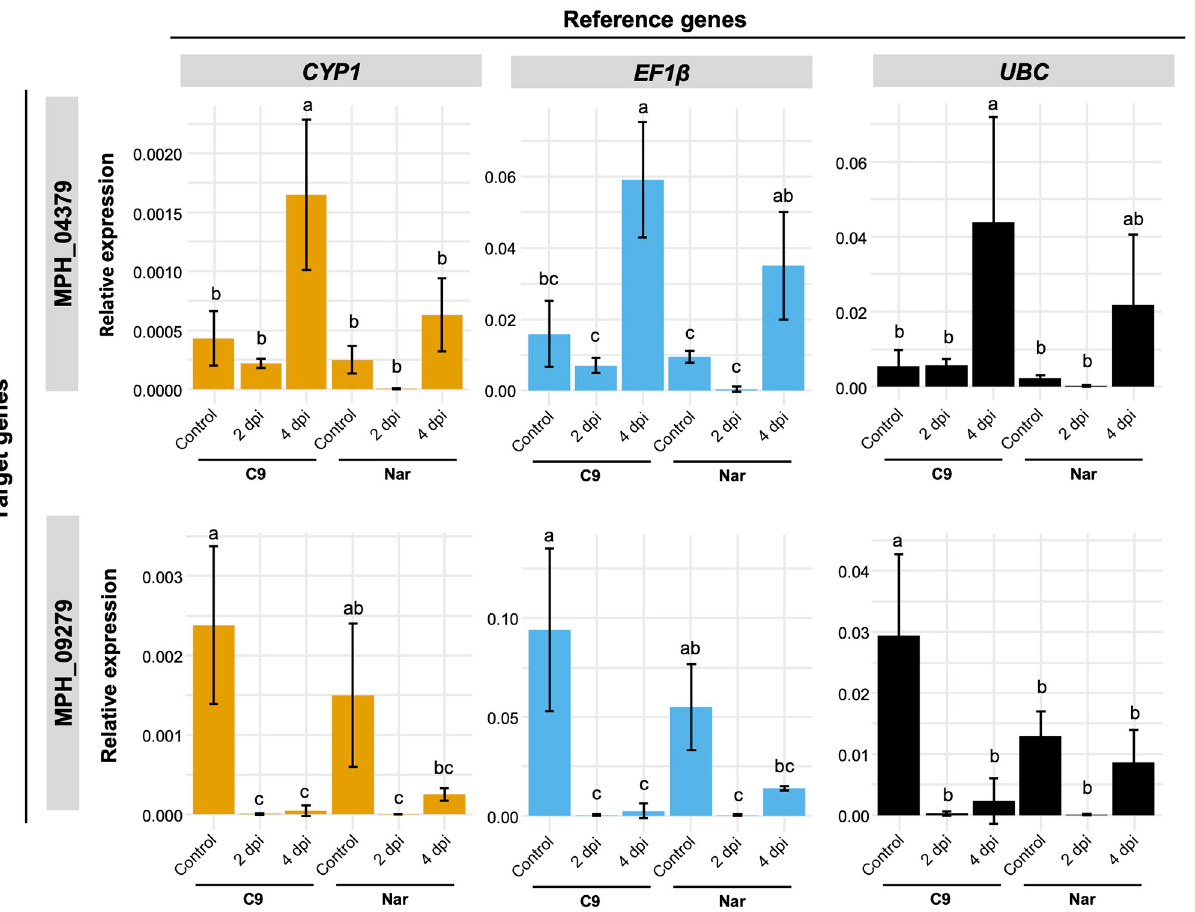
Fig 3. Expression of two cutinase genes of M . phaseolina during soybean root infection. Expression analysis of cutinase genes MPH_04379 (top) and MPH_09279 (bottom) was performed to validate the reference genes. RNA was extracted from soybean roots infected with isolate C9 and Nar at 2 and 4 dpi. CYP1 (left) and EF1 β (middle) were used as recommended internal controls, and UBC (right) was used as worst internal control. Data are mean ± standard deviation of at least three biological replicates. Different letters above the bars indicate significant differences at P < 0.05 (Tukey’s